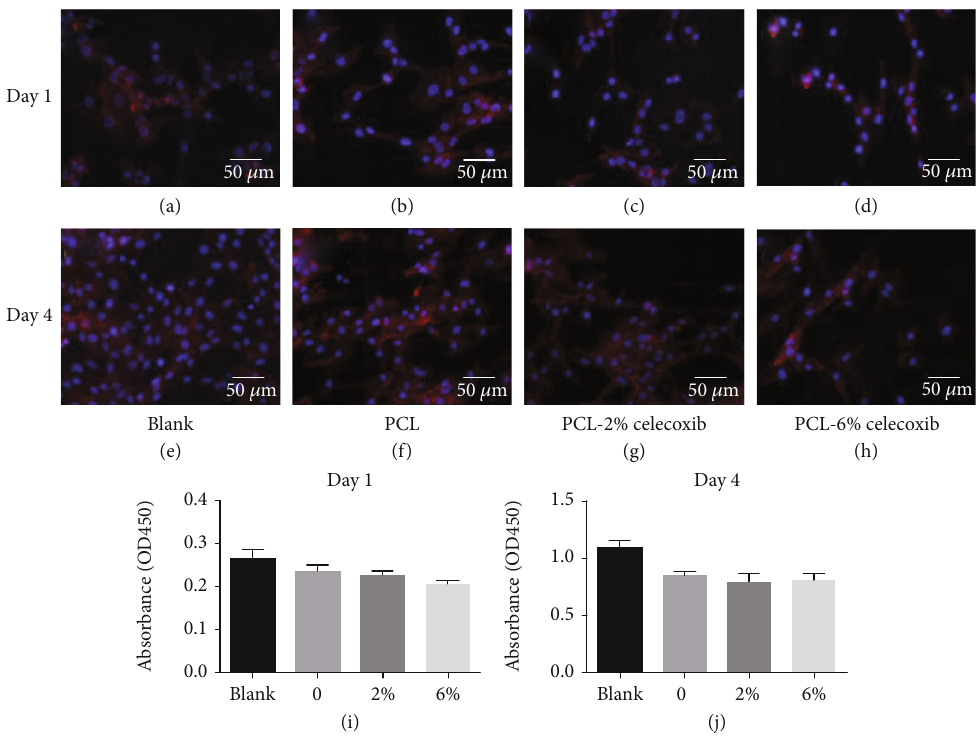
Figure 2: Fluorescence micrographs of chicken embryonic fi broblasts (UMNSAH/DF-1) after 24 h and 4 days of incubation. The cytoskeleton was stained red, and the nuclei were stained blue on the surfaces of the fi brous membranes. The fi broblast proliferation on the sample surfaces ( n = 3 ), blank (a, e), PCL fi brous membranes (b, f), PCL-20%-CEL fi brous membranes (c, g), and PCL-60%-CEL fi brous membranes (d, h).